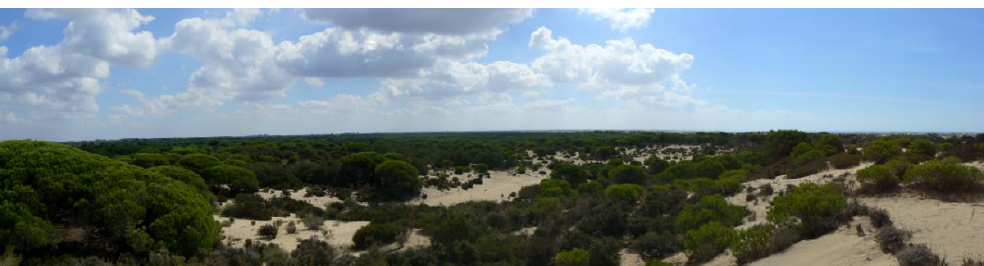
Figure 1. Natural Park of